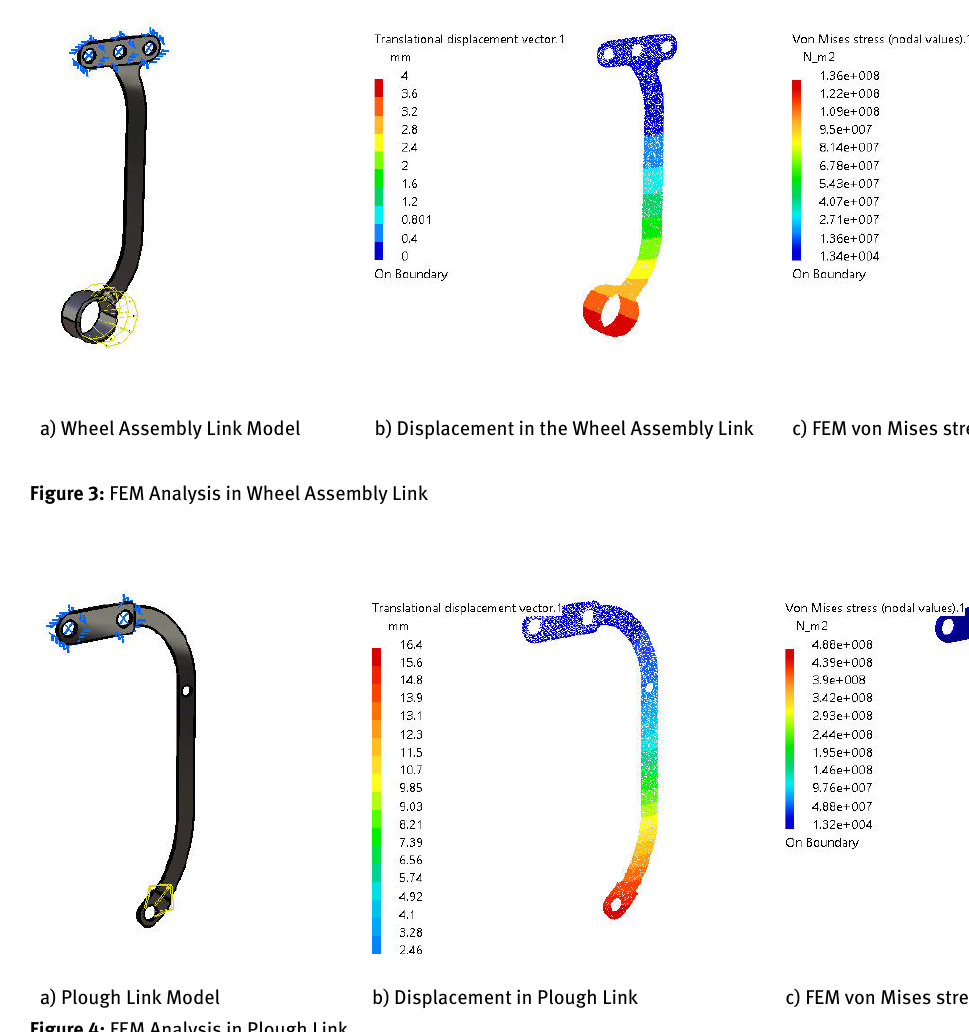
Figure 4: FEM Analysis in Plough